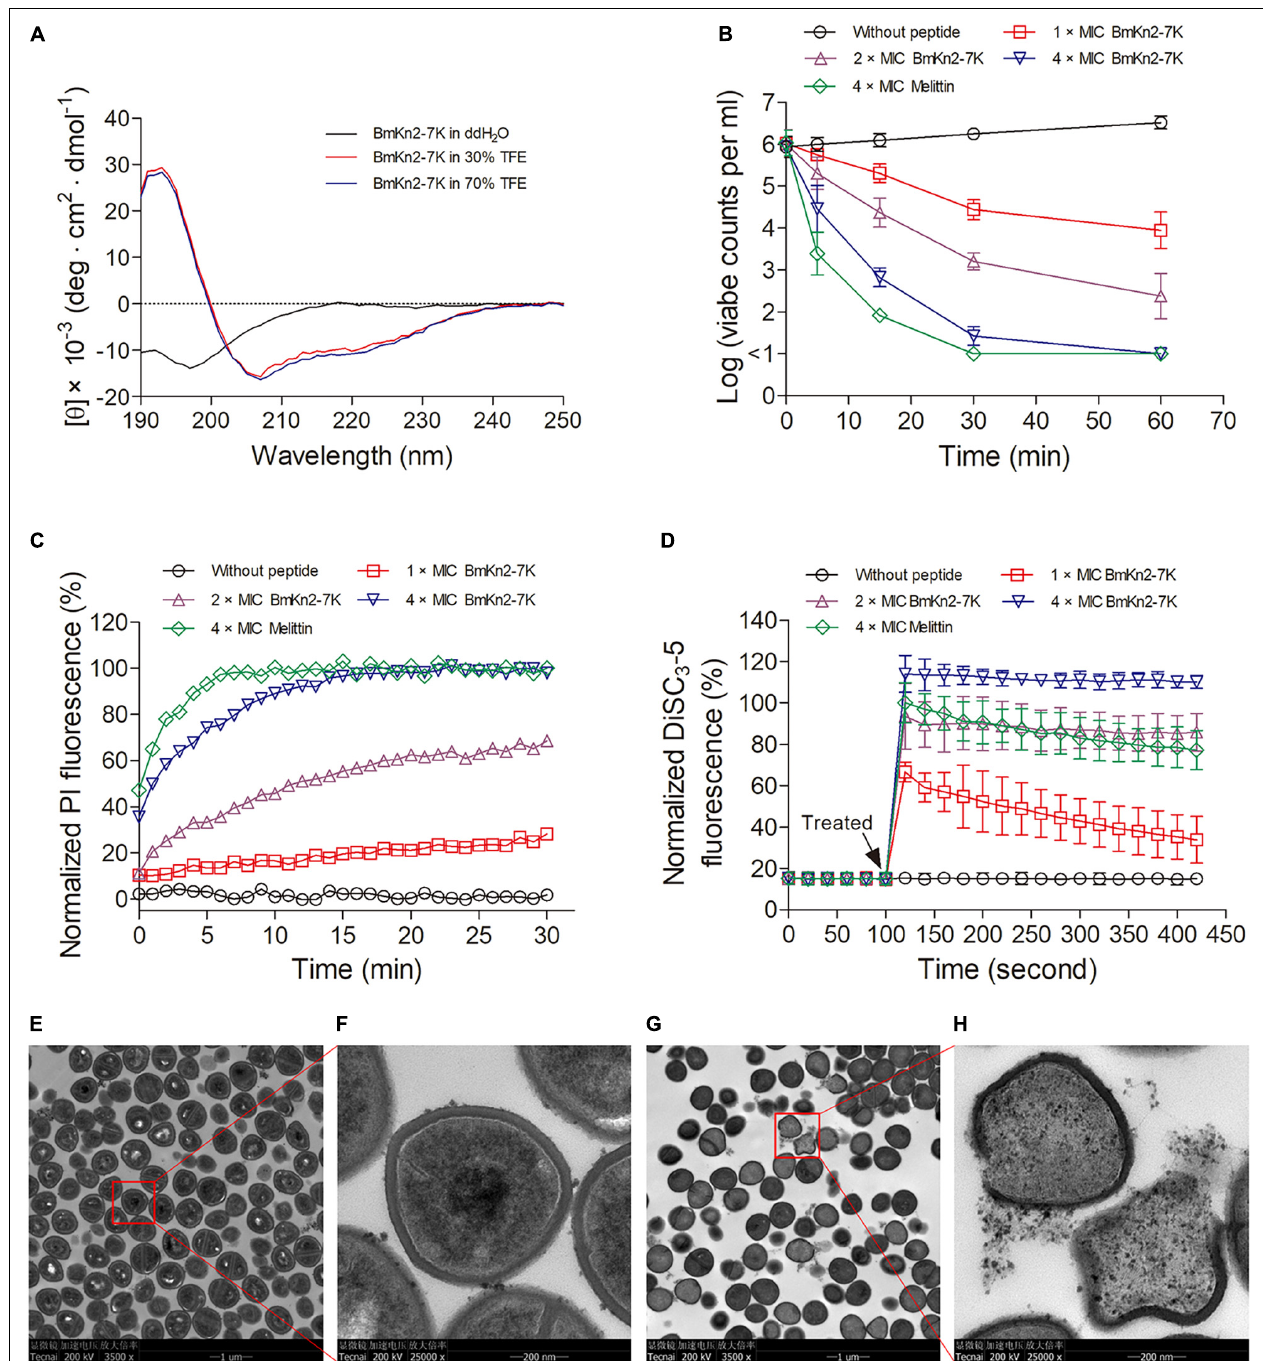
FIGURE 4 | Antibacterial mechanism of BmKn2-7K. (A) CD spectra of BmKn2-7K (150 µ g ml - 1 ) in ddH 2 O, 30% and 70% TFE solutions. (B) Time-killing kinetics of BmKn2-7K against S. aureus ATCC29213. The surviving bacterial cells were determined by counting the clonies on the agar after overnight incubation. (C) Normalized PI fluorescence of S. aureus ATCC29213 treated with BmKn2-7K. (D) Normalized DiSC 3 -5 fluorescence of S. aureus ATCC29213 treated with BmKn2-7K. In Figures 4B–D , the peptide concentrations were 0 × MIC (circle), 1 × MIC (square), 2 × MIC (upward triangle) or 4 × MIC (downward triangle). The sample treated with 4 × MIC melittin (diamond) was presented as the positive control. The data represent average ± standard error of three independent experiments. (E,F) Transmission electron microscopy (TEM) analysis of untreated S. aureus ATCC29213 and (G,H) the bacteria incubated with 1 × MIC BmKn2-7K for 0.5 h. (F,H) represent pictures of (E,G) (red box) with greater magnification.